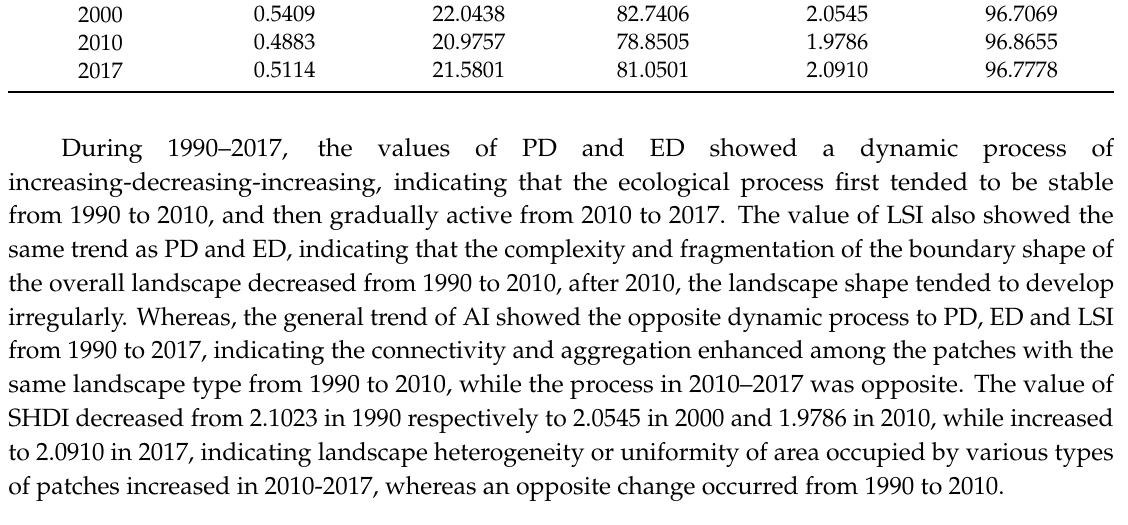
Table 5. Calculation results of landscape pattern index in the whole study